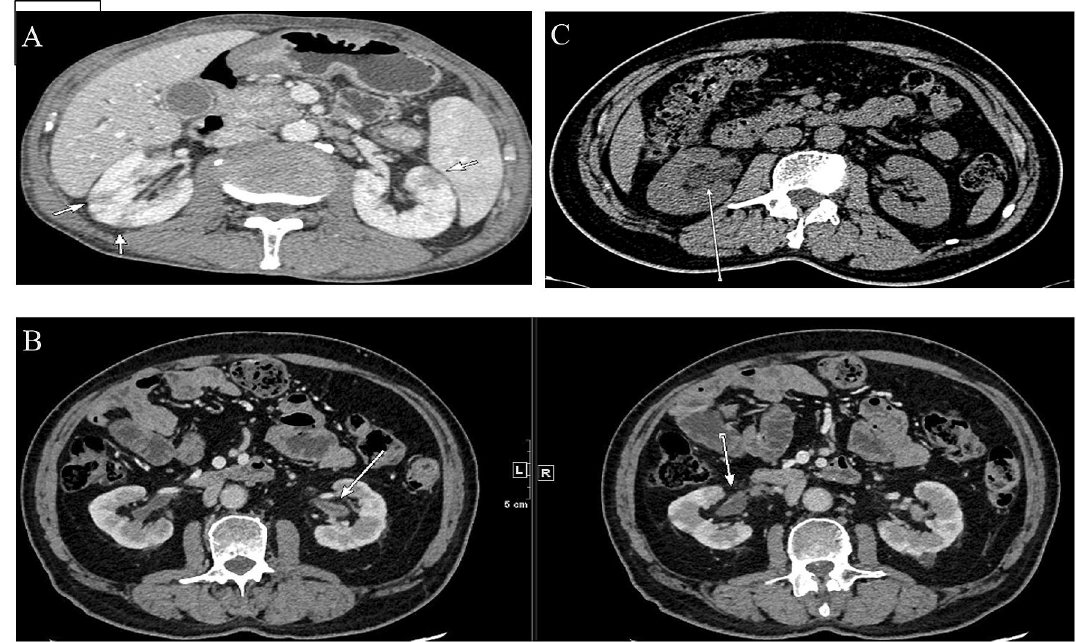
Figure 4. Representative contrast-enhanced CT imaging of IgG4-RKD+ . ( A ) Multiple low-density lesions in the bilateral kidneys (arrows). ( B ) ureteric obstruction and hydronephrosis related to RPF (arrow). ( C ) Renal pelvis thickening with smooth intraluminal surface